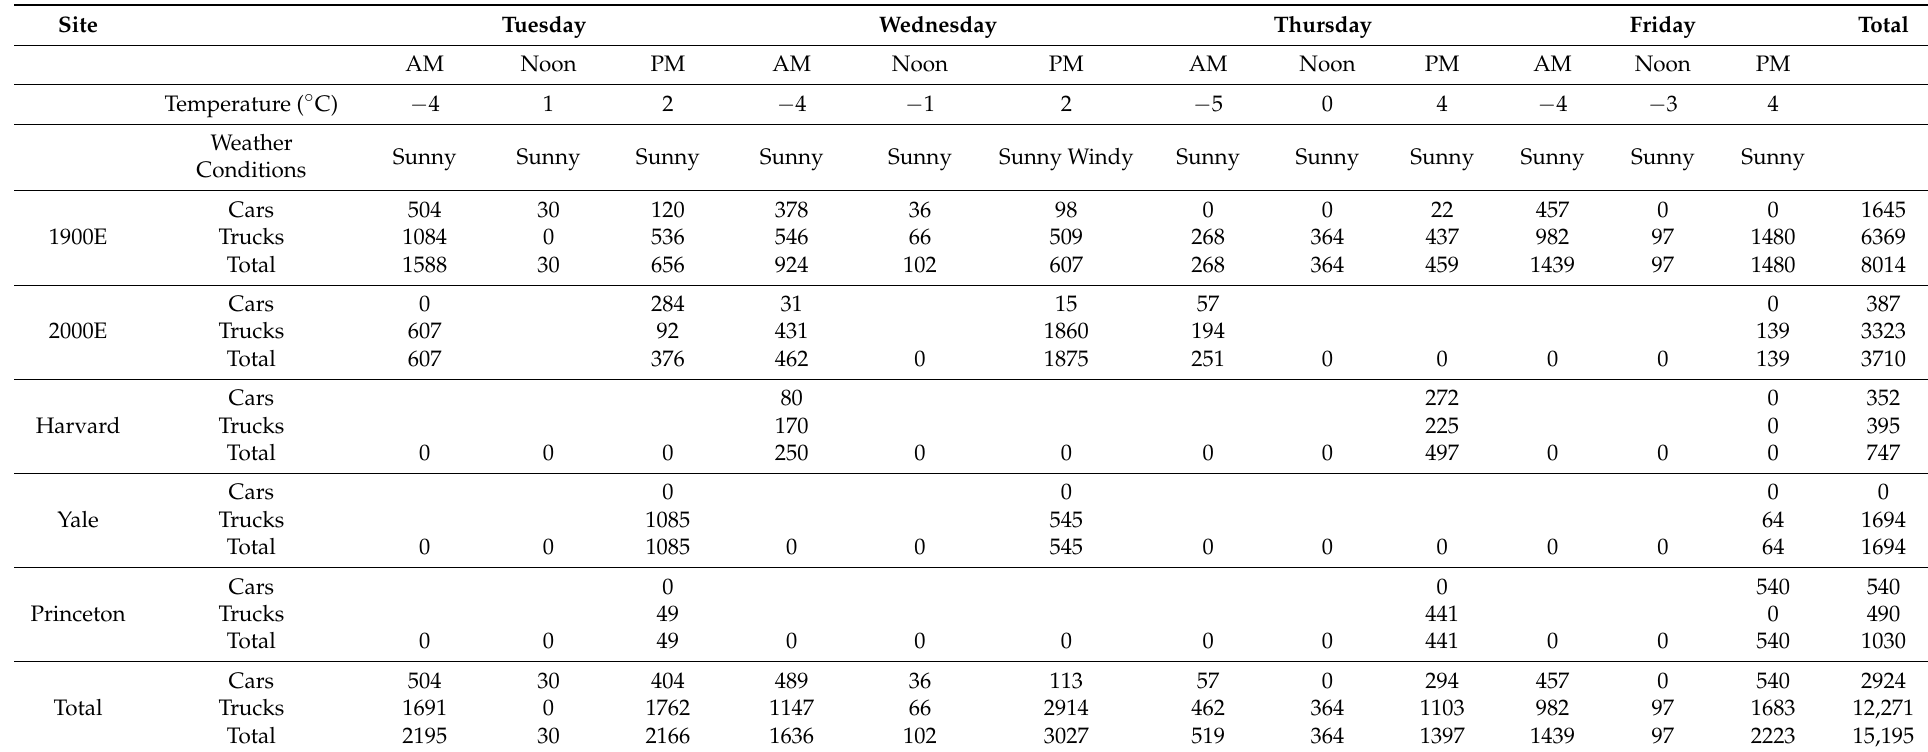
Table 10. Idling time (seconds) during the post-intervention week: 18–21 February